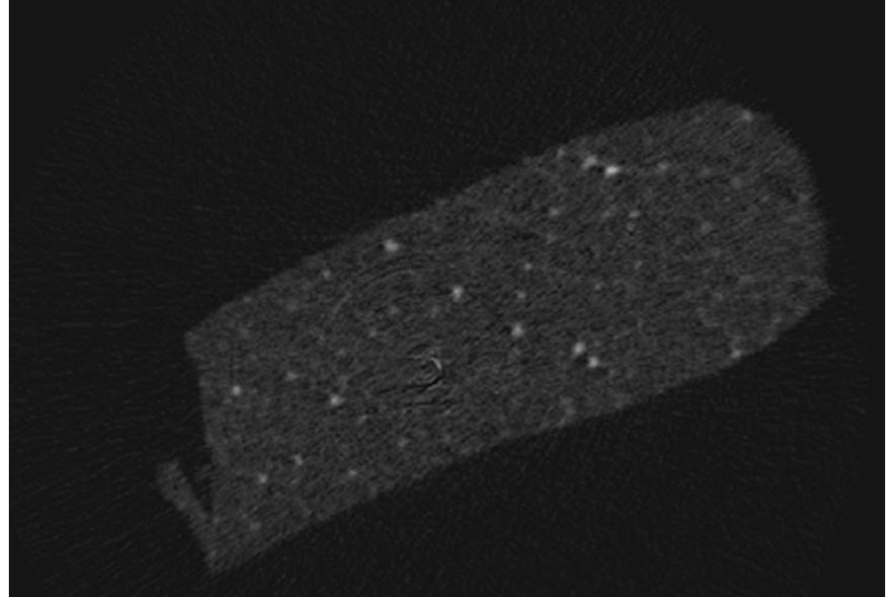
Figure 1. X-ray SKYSCAN 1174 microtomograph (8% ceramic nanofiller in epoxy matrix).